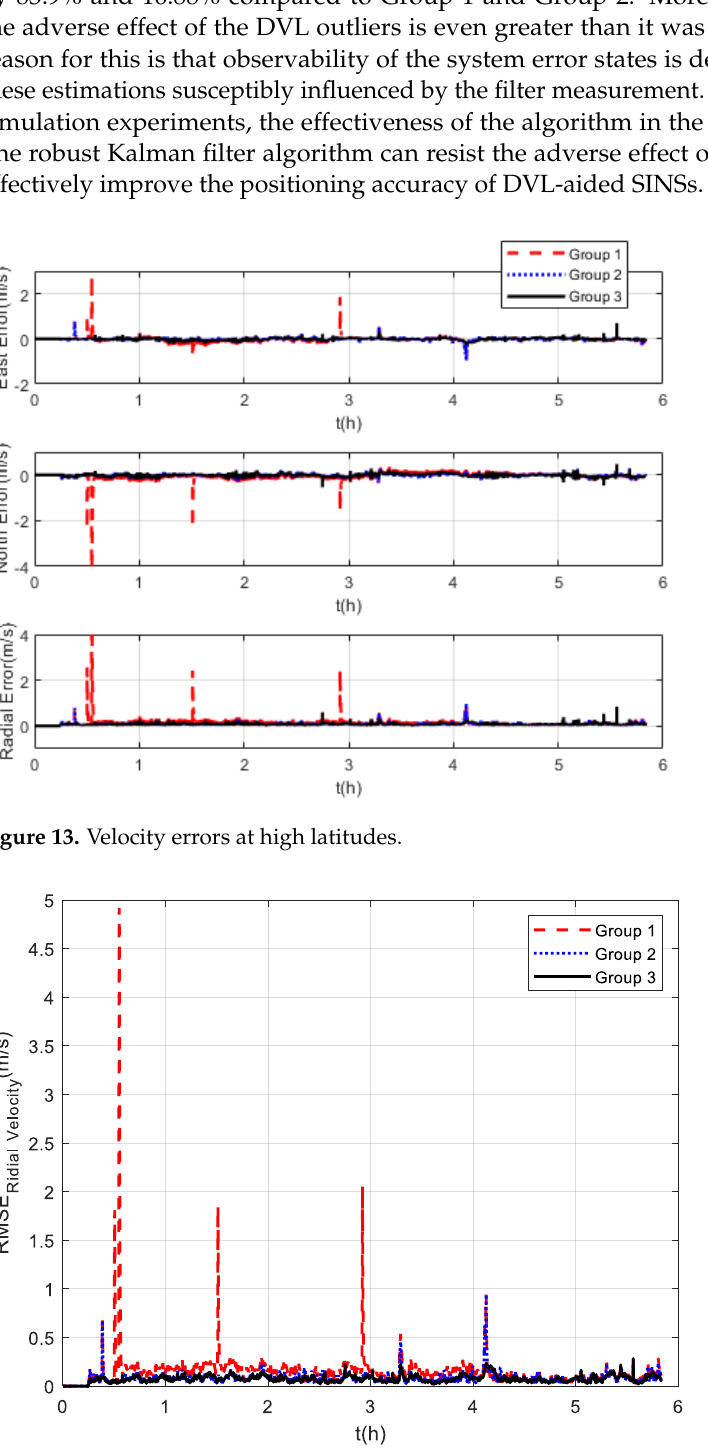
Figure 14. RMSE of radial velocity at high latitudes.